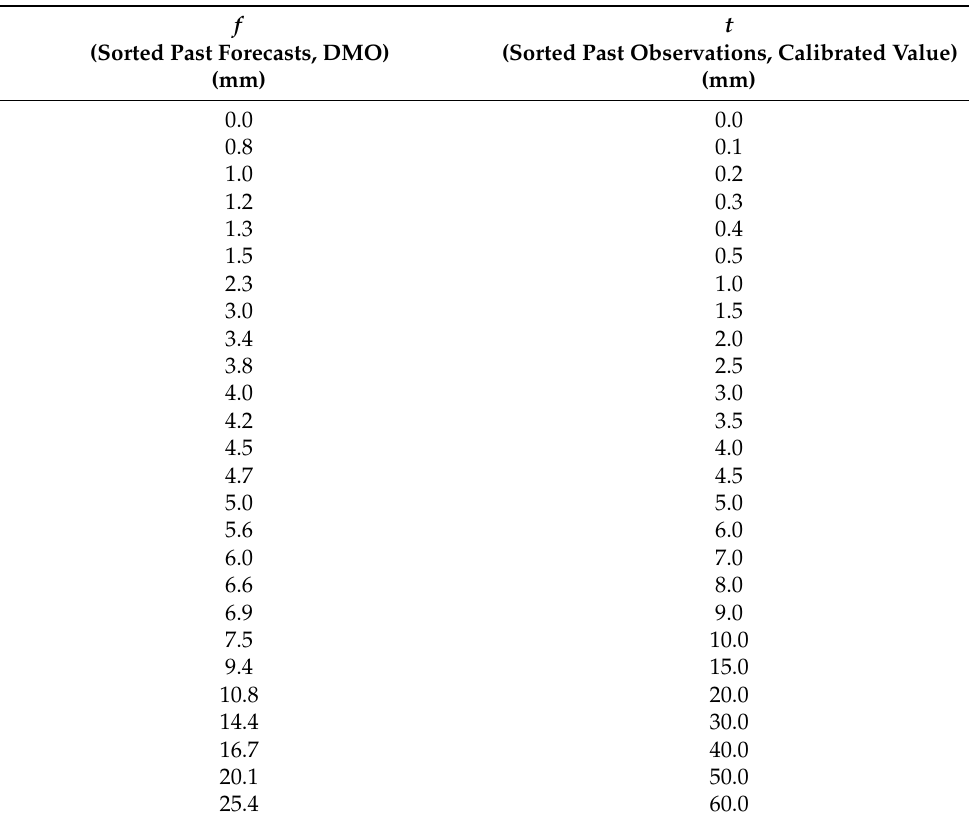
Table 1. An example of the f-t conversion table (this is the f-t table of the Adaptive Table method for ECMWF as on 1 January 2014 00 h, the start of the verification period). t f (Sorted Past Observations, Calibrated Value) (Sorted Past Forecasts, DMO) (mm)